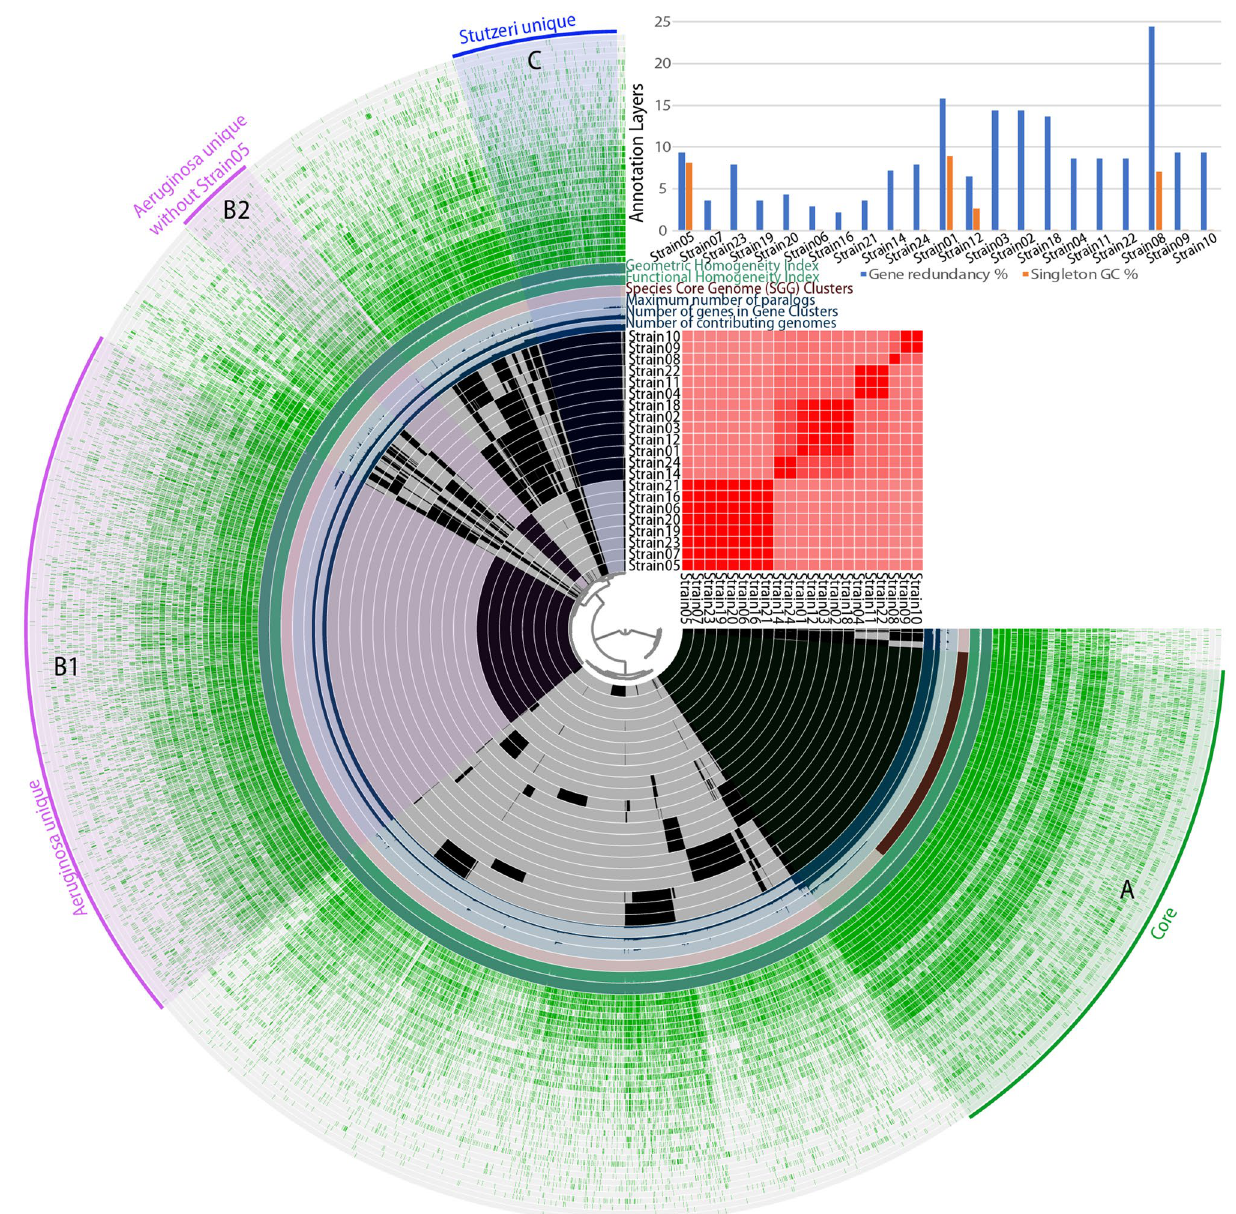
Figure 5. Anvi’o representation of the pangenome of the 21 Pseudomonas genomes. The first 21 layers represent each genome, and the black coloration signifies the existence of a Gene Cluster (GC). To the right is given an ANI percentage identity heatmap of the same genomes. The subsequent 6 layers correspond to various statistics related to the analysis i.e. the number of contributing genomes per GC, number of genes per GC, maximum number of paralogs per GC, Species Core Genome Clusters, Functional Homogeneity Index and Geometric Homogeneity Index. The last 38 layers represent the various annotation sources for each GC and the green coloration signifies the existence of annotation. “A” represents the common GCs to all 21 strains (Core genome). “B1” represents the GCs unique to the Aeruginosa group strains and “C” represents the GCs which are unique to the Stutzeri group strains. “B2” represents the GCs specific to the Aeruginosa group strains but without Strain05 which has no GCs in this bin. The bar chart at the top right represents the gene redundancy (blue bar color) and the singleton GC (orange bar color) per